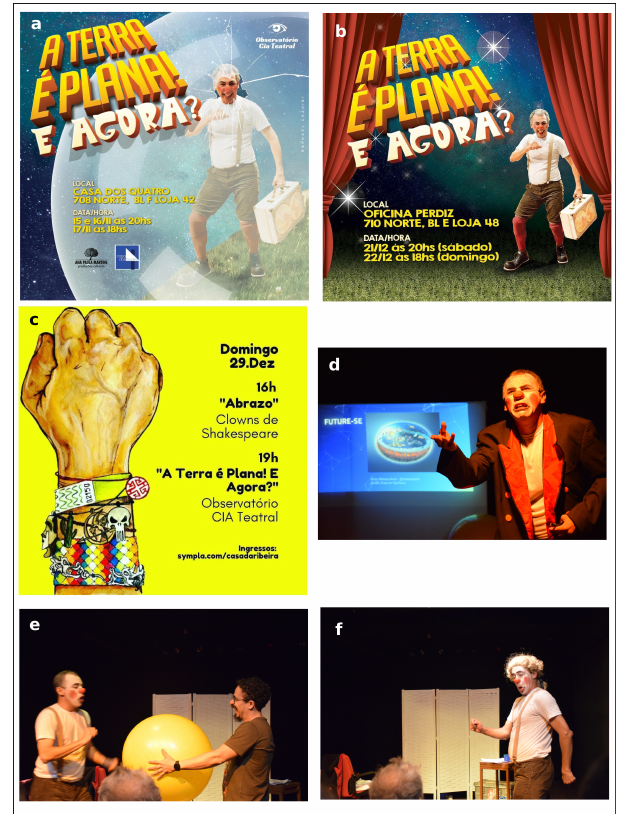
Figure 2. The posters of the shows that took place in Casa dos Quatro (a) , Teatro Oficina Perdiz (b) and Casa da Ribeira (c) ; and photos (d, e, f) taken during the play by Hugo de Freitas.